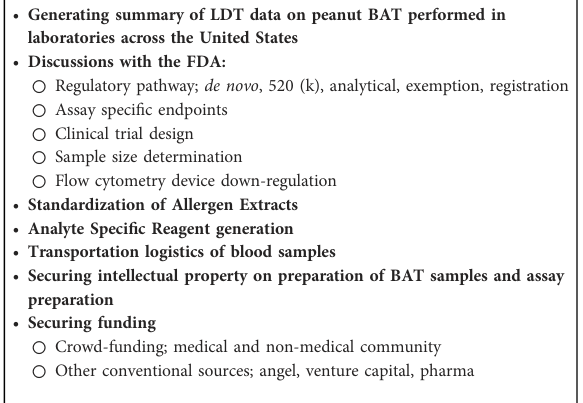
TABLE 3 Regulatory clearance pathway for a BAT kit. (cid:129) Generating summary of LDT data on peanut BAT performed in laboratories across the United States (cid:129) Discussions with the FDA: ○ Regulatory pathway; de novo , 520 (k), analytical, exemption, registration ○ Assay speci fi c endpoints ○ Clinical trial design ○ Sample size determination ○ Flow cytometry device down-regulation (cid:129) Standardization of Allergen Extracts (cid:129) Analyte Speci fi c Reagent generation (cid:129) Transportation logistics of blood samples (cid:129) Securing intellectual property on preparation of BAT samples and assay preparation (cid:129) Securing